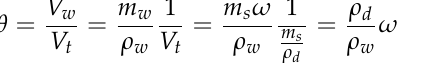
Figure 3. Relationship between basal spacing and water content.